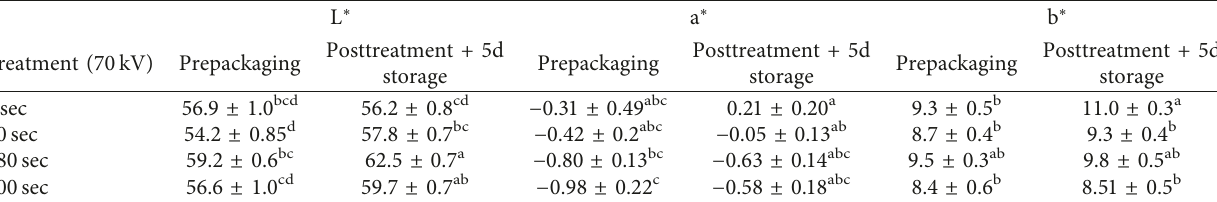
Table 3: Effect of cold plasma treatment time on CIE L ∗ a ∗ b ∗ values of raw chicken breast fillets (mean ± SE). L ∗ a ∗ b ∗ Posttreatment + 5d Posttreatment + 5d Posttreatment + 5d Prepackaging Prepackaging Treatment (70kV) Prepackaging storage storage storage